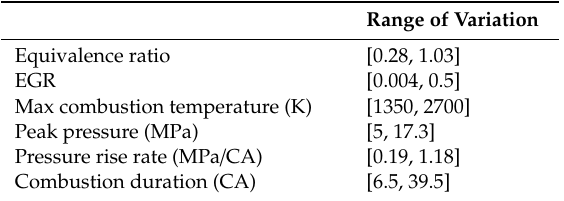
Table 4. The variation range of combustion control